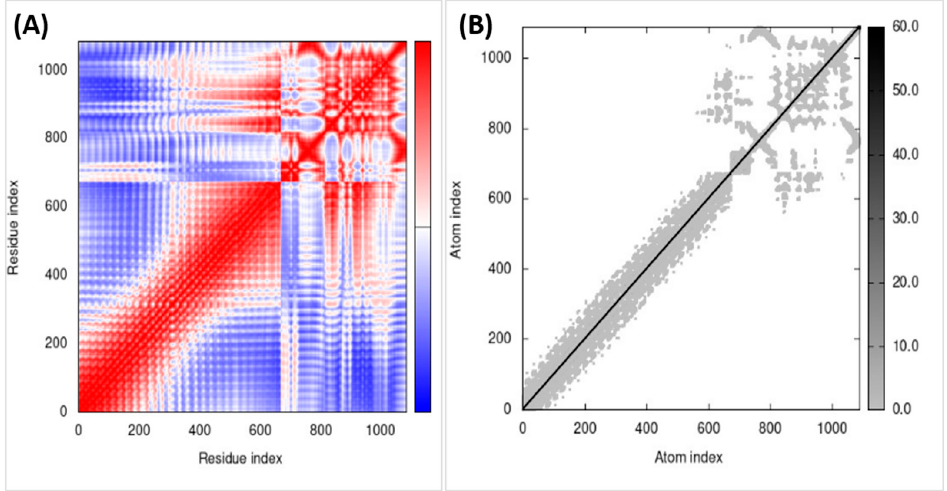
Figure 7. ( A ) Covariance matrix indicates coupling between pairs of residues, i.e., whether they experience correlated (red), uncorrelated (white), or anticorrelated (blue) motions. ( B ) The elastic network model defines which pairs of atoms are connected by springs. Each dot in the graph represents one spring between the corresponding pair of atoms. Dots are colored according to their stiffness; the darker grays indicate stiffer springs, and vice versa.